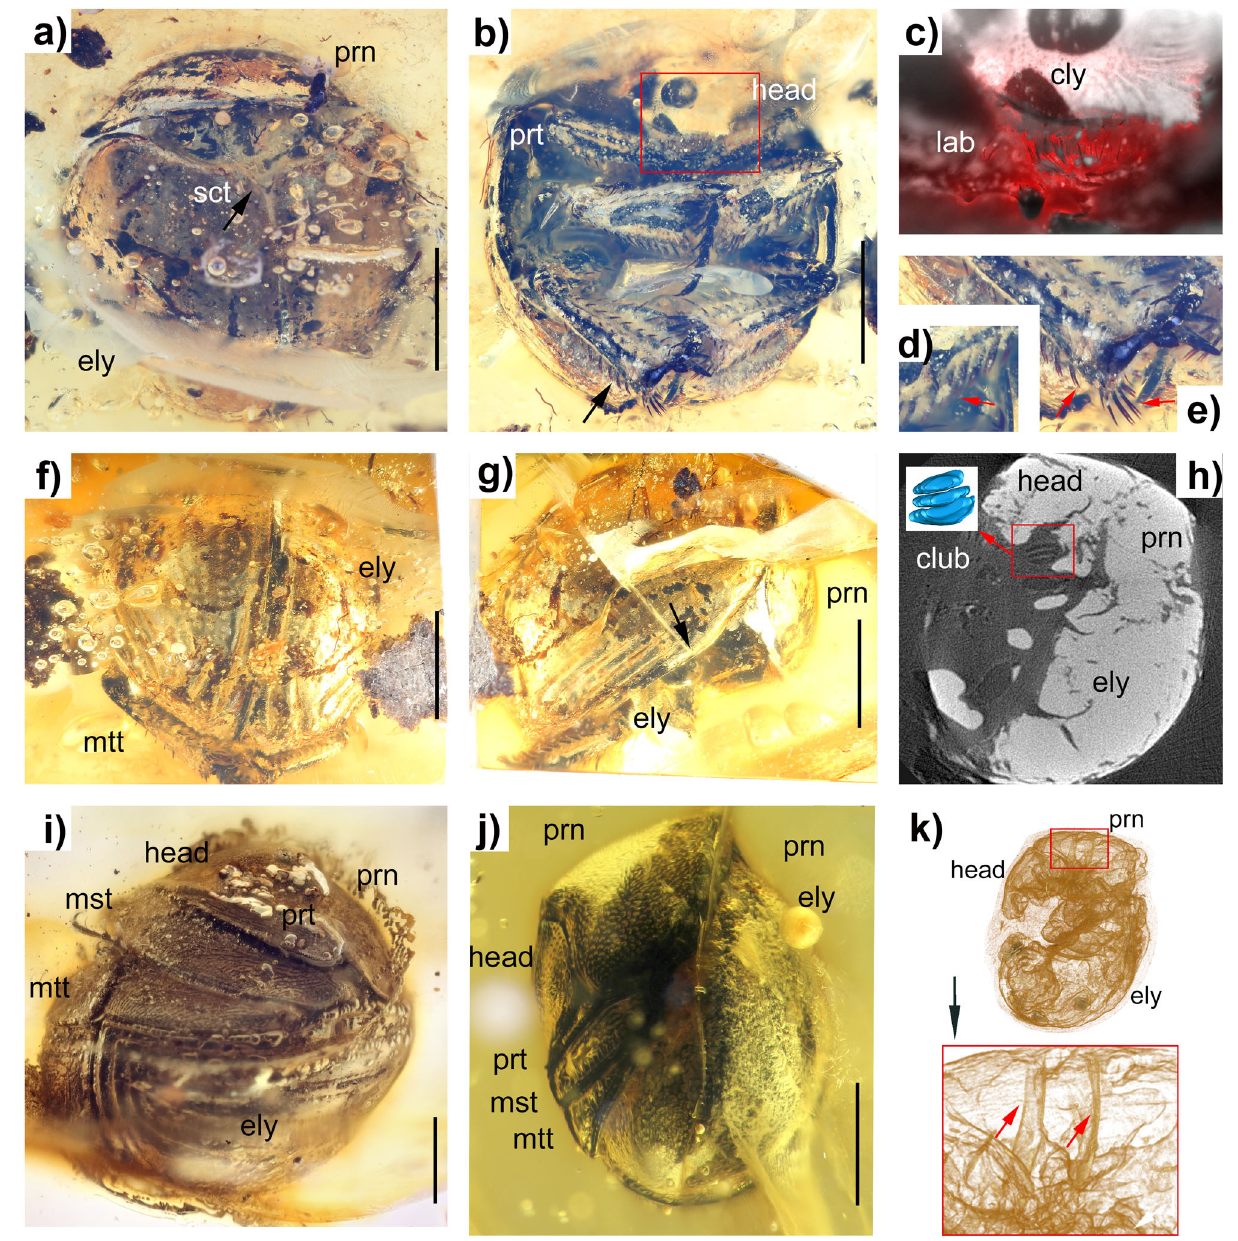
Fig. 2 Images of Mesozoic and Ceonzoic amber of Ceratocanthinae. a – h Palaeopycnus circus Lu, Ballerio & Bai sp. nov. (holotype). a General habitus, dorsal view. b General habitus, ventral view, with details of the rectangular frame shown in c . The black arrow points to bi fi d setae on the tibia (details in d and e ). c Head, showing the clypeus and labrum under red epi fl uorescence. d Left mesotibia; the red arrow points to bi fi d setae on the posterior part. e Right metatibia; red arrows point to bi fi d setae on the posterior and terminal parts. f Posterior part of the dorsal view. g General habitus, lateral view. The black arrow points to the marginal area of the elytron. h Microtomographic slide showing an antenna in lateral view, where the red rectangle shows the lamellate club of the antenna. The screenshot image from the 3D surface model of the club is shown in the white rectangle. i Ceratocanthus huarongii Lu, Ballerio & Bai sp. nov. (holotype). General habitus, lateral view. j , k Nesopalla succini Lu, Ballerio & Bai sp. nov. (holotype). j General habitus, lateral view. k Lateral view, where the red rectangle and arrows show prosternal apophyses that reach the inner wall of the pronotum. Scale bars: 1 mm. Abbreviations: prn, pronotum; ely, elytron; sct, scutellum; prt, protibia; cly, clypeus; lab, labrum; mad, mandible; mst, mesotibia; mtt,